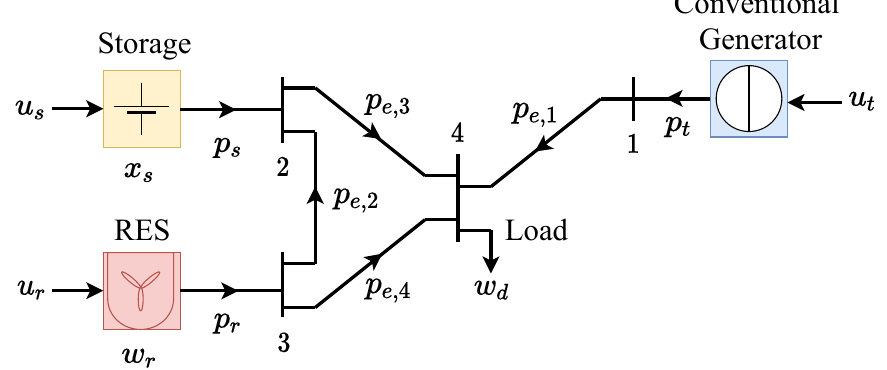
Figure 2. MG used for operation control as a running